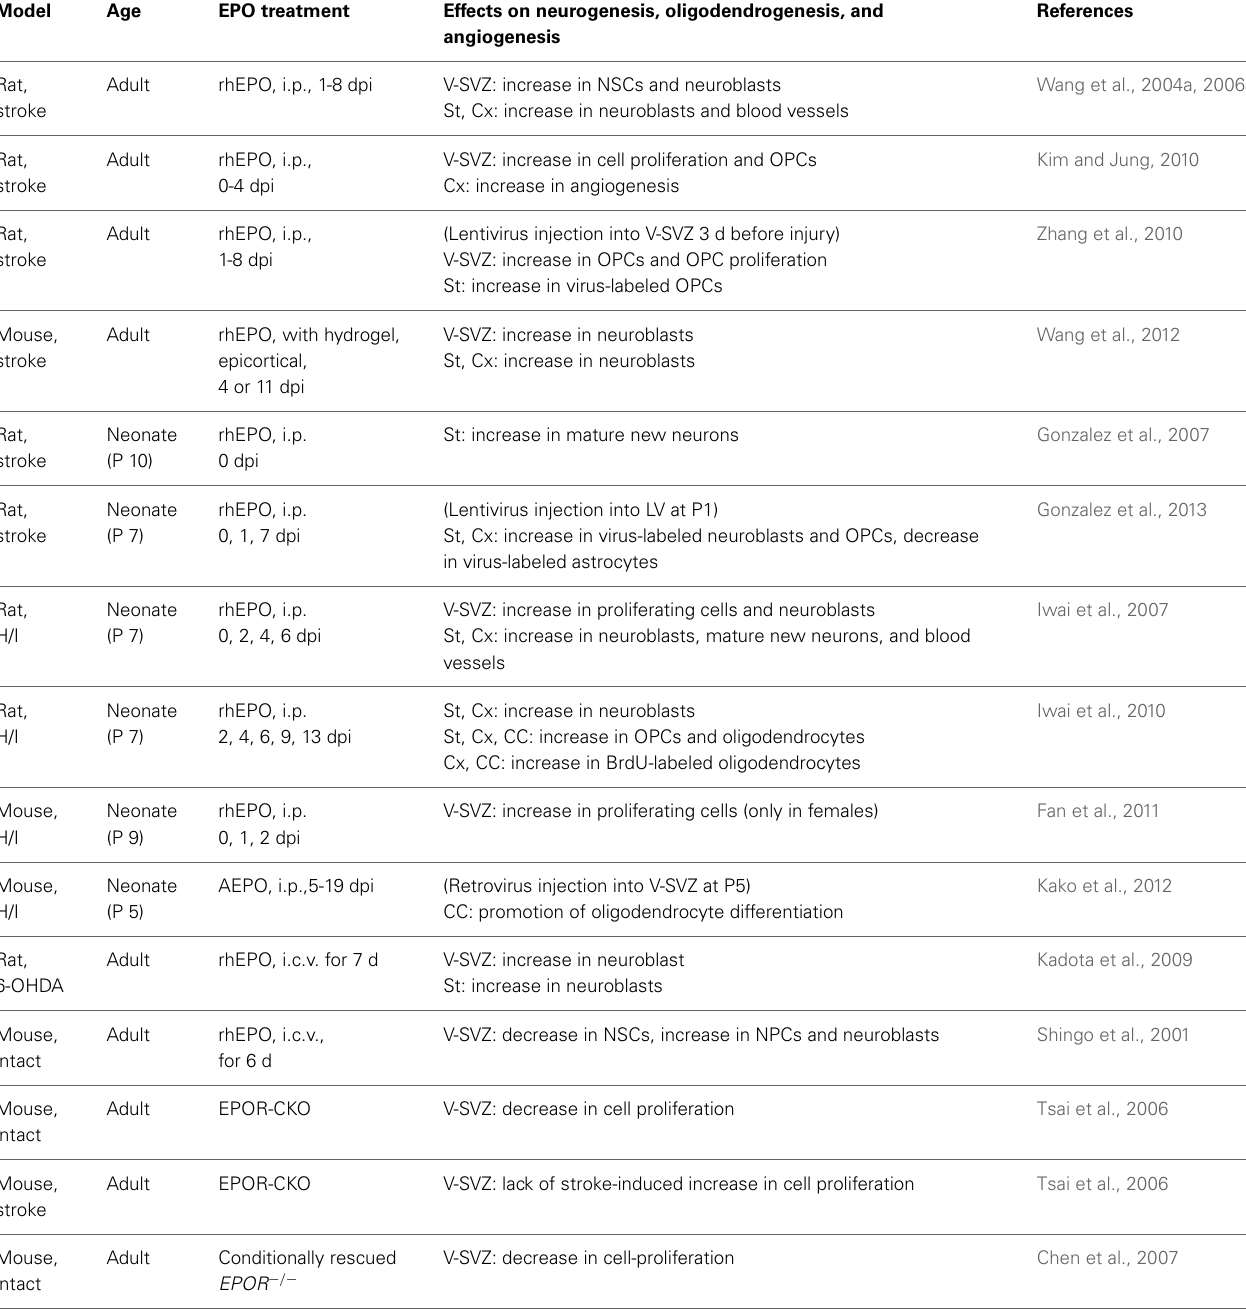
Table 1 | EPO’s effects on V-SVZ neurogenesis/oligodendrogenesis.